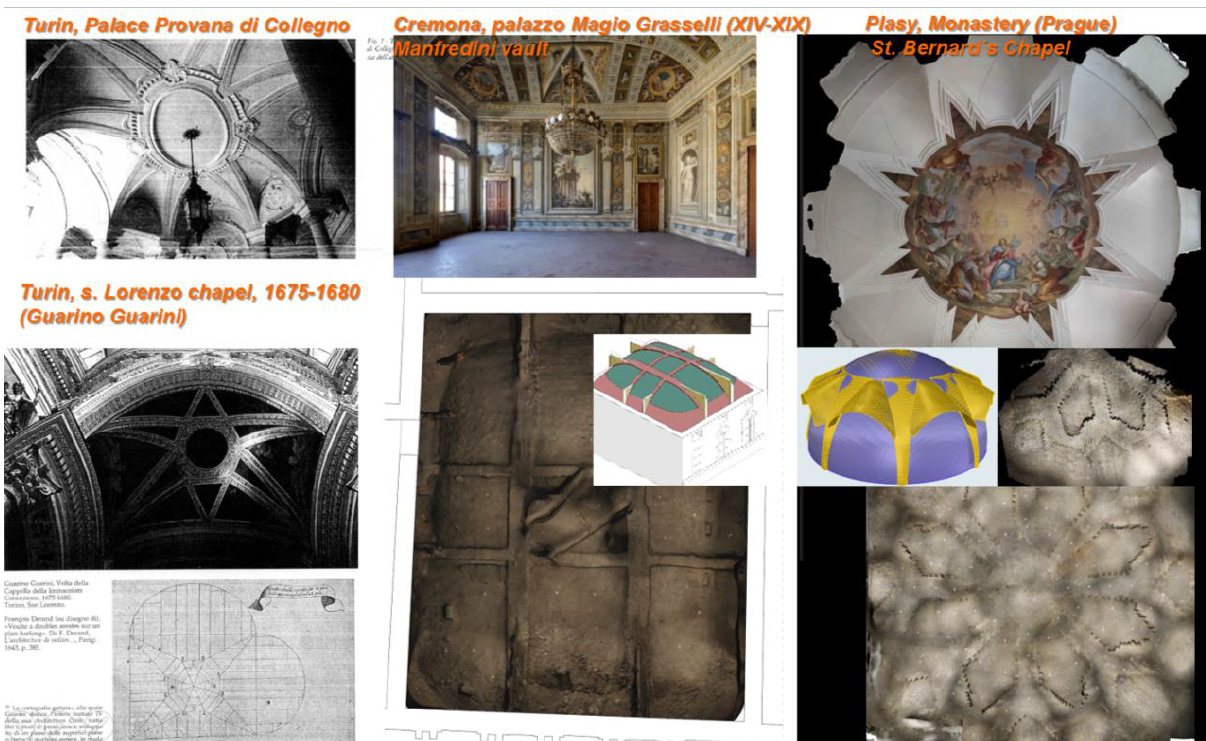
Figure 6. The Hub platform implementation will allow to give back a ‘PanEu picture’ with un-expected correlations of traditions, skilled workers, permanencies and mutation across space/time, and, thus, the socioeconomic framework of the different periods. Here it is illustrated the case of a sample of the multiplicity of mixed arched-vaulted systems in Turin, Cremona and Plasy